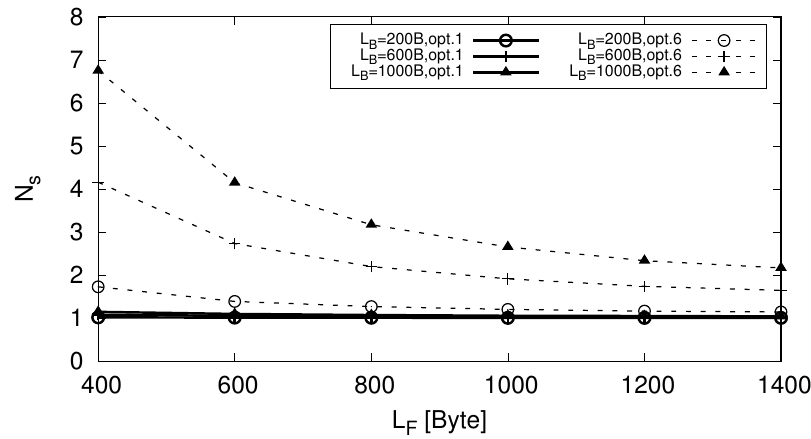
Figure 10. Average number of segments ( N S ) required to send a backhaul (BH) packet as a function of payload length L F for different BH packet length L B using CPRI opt. 1 and